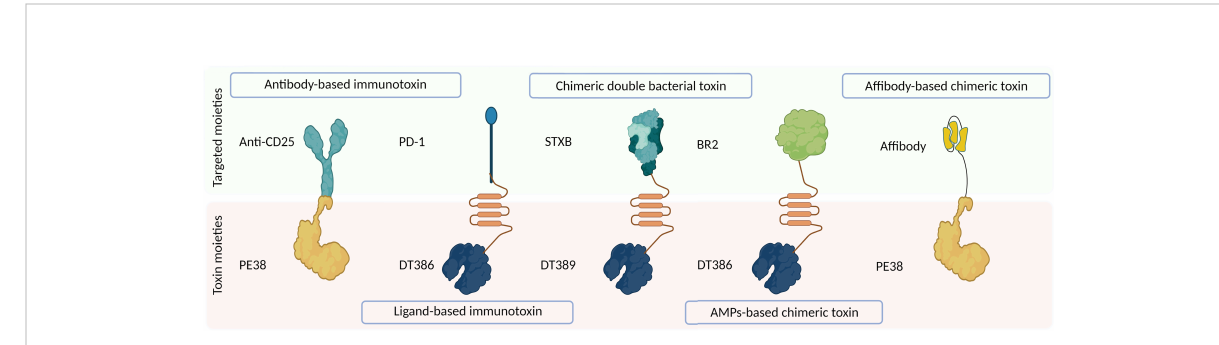
FIGURE 3 The schematic representation of different types of bacteria-derived chimeric toxins. DT, diphtheria toxin; truncated DTs, DT386 and DT389; STXB, Shiga-like toxin-B; BR2, buforin II; PE, Pseudomonas exotoxin A; PD1, programmed cell death